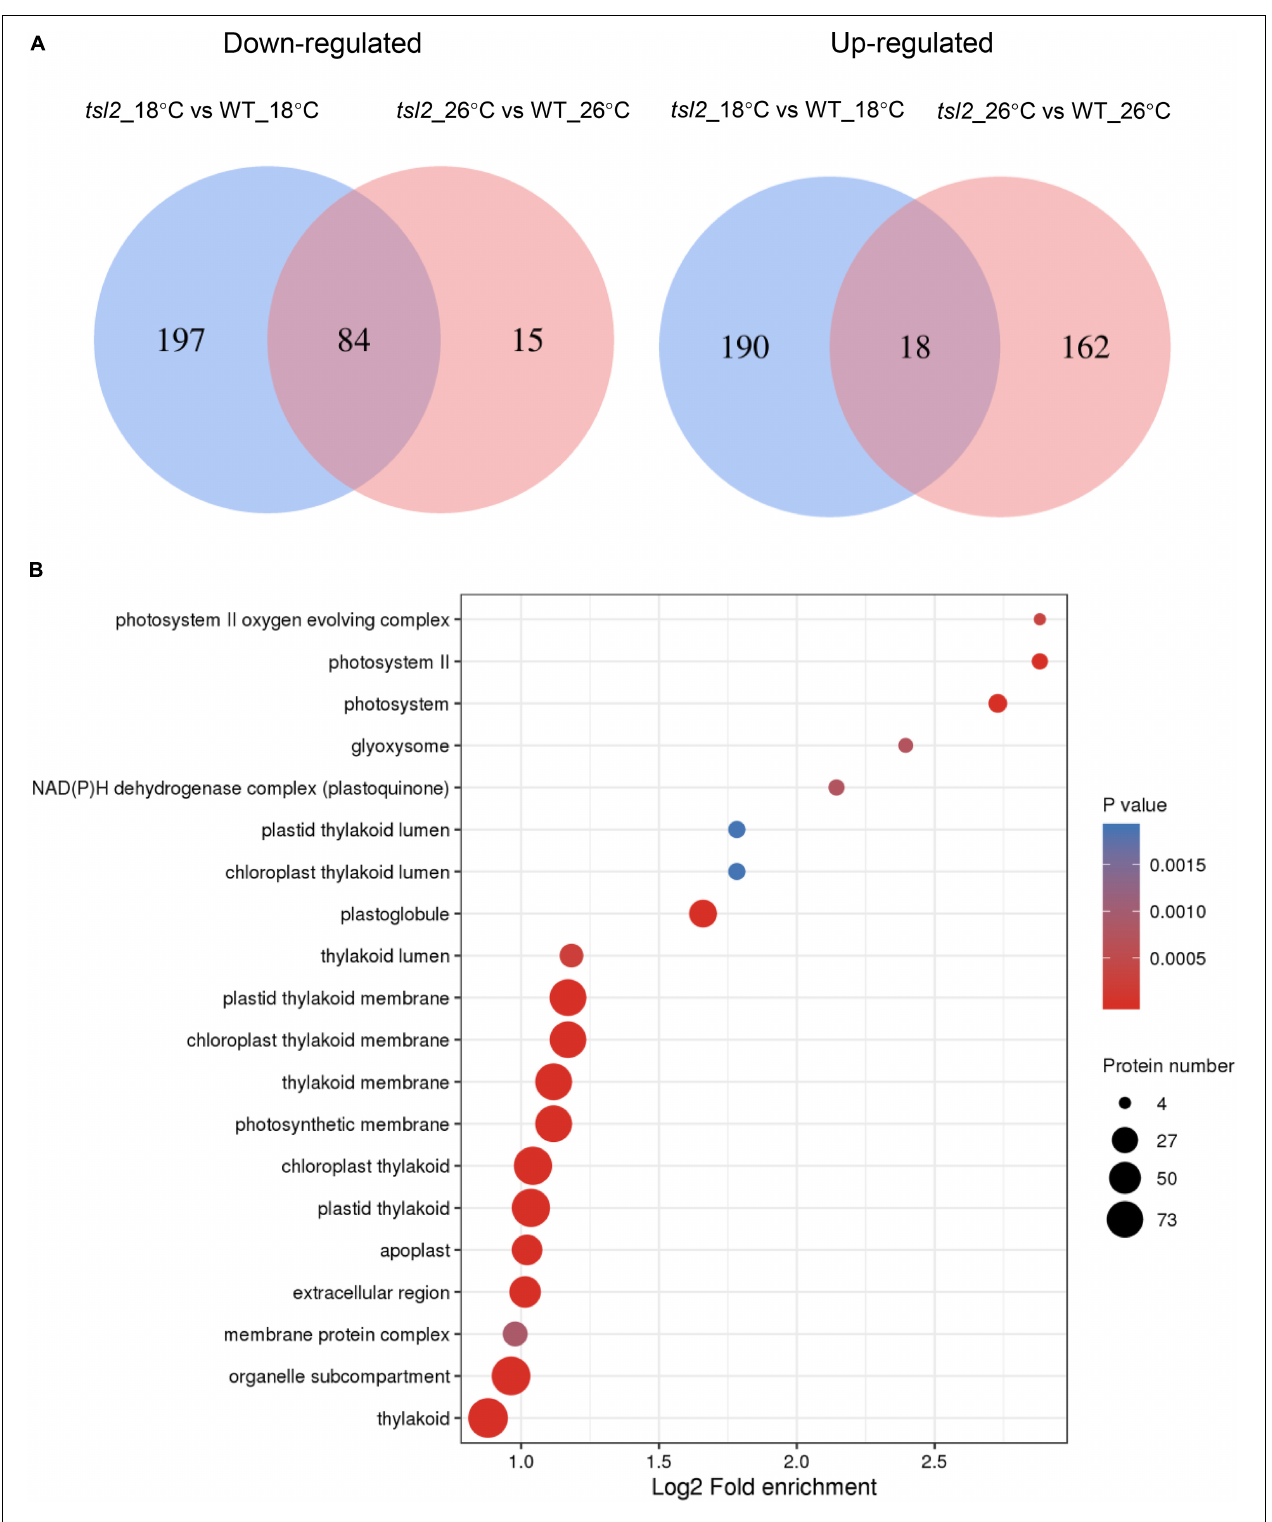
FIGURE 7 | TSL2 regulates chloroplast protein accumulations. (A,B) Proteomic analysis of chloroplast proteins in WT and tsl2 mutant plants. Venn diagrams show the numbers of overlapping and non-overlapping proteins that were upregulated or downregulated under two temperature conditions (A) . Criteria for differential expression were set as q ≤ 0.05, fold change (FC) ≥ 1.3 for upregulation or FC ≤ 0.7 for downregulation. GO analysis of 281 downregulated proteins in tsl2 mutant at 18 ◦ C is shown in (B) .